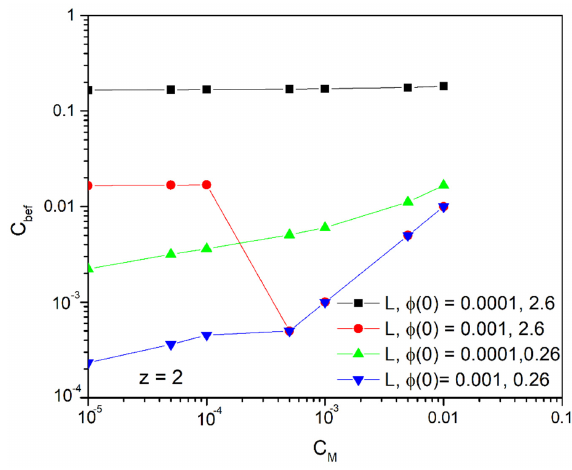
Figure 6. Initial concentration, 𝐶 (cid:3029)(cid:3032)(cid:3033) as a function of the concentration in the middle of the con- ) after applying the field for various duct widths (m) and potentials 𝜑(0) (V). ductor, 𝐶 (cid:3014) ( (cid:2923)(cid:2925)(cid:2922) (cid:2923)(cid:2871) For duct widths of 𝐿 = 0.001 m, the method is applied in the case of the potential 𝜑(0) = 0.26 V (blue line) when we want to achieve concentrations 𝐶 (cid:3014) below 0.001 mol/m 3 . The case in which 𝜑(0) = 2.6 V , 𝐿 = 0.001 m, corresponding to the red line, is discontinuous and we consider that it is reliable only in the part where it coincides